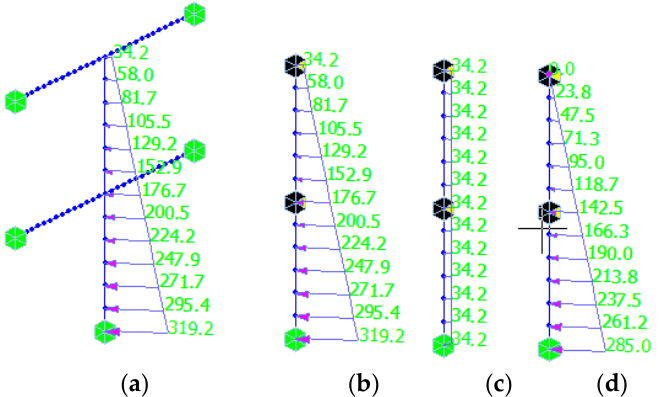
Figure 12. Two-dimensional simplified simulation model of the wall column (unit: kN/m). ( a ) The wall column model with the frame beam and trapezoidal distributed load; ( b ) The wall column model with elastic supports and trapezoidal distributed load; ( c ) The wall column model with elastic supports and uniformly distributed load; ( d ) The wall column model with elastic supports and triangularly distributed load.